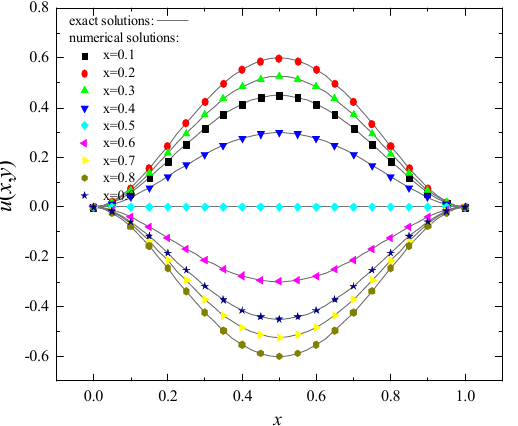
Figure 6. The exact solutions and the numerical solutions obtained by the EFG, VMEFG and DS-GIEFG methods.